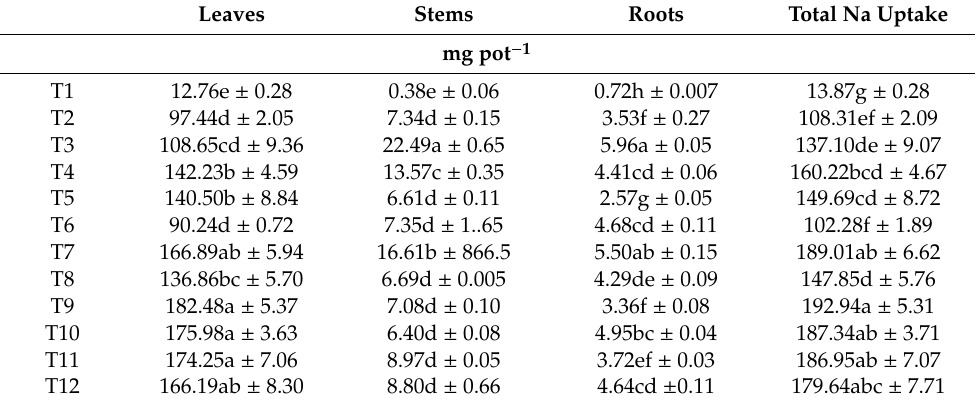
Table 8. E ff ects of treatments on sodium uptake of leaves, stems, and roots, and total sodium uptake of maize at tasseling stage.